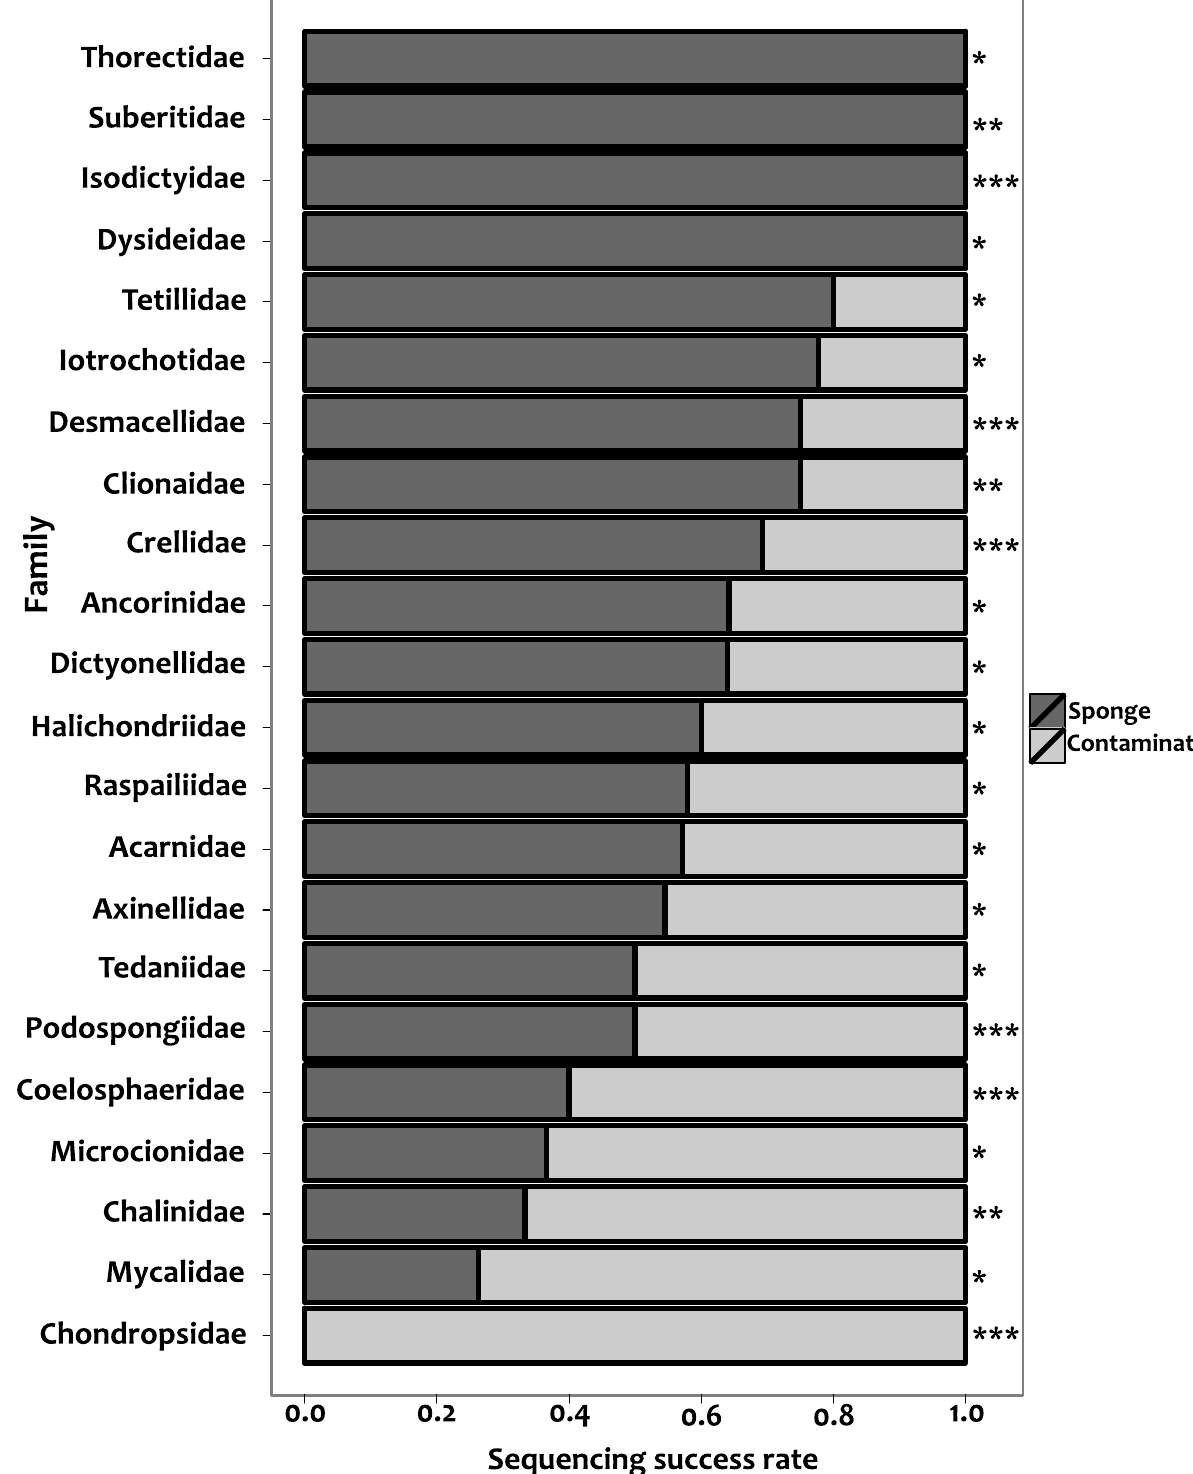
Figure 2. Sequencing success rates per sponge family. Grey and black colours represent sequences corresponding to non-target organisms and poriferans, respectively. The included families correspond to the families used for the analysis of PCR success, and were analised in the generalised linear model. Asterisks on the right side correspond to the different family groups analysed: *: Acarnidae, Ancorinidae, Axinellidae, Dictyonellidae, Dysideidae, Halichondridae, Iotrochotidae, Microcionidae, Mycalidae, Plakinidae, Raspailidae, Tedaniidae, Tetillidae and Thorectidae; **: Chalinidae, Clionaidae and Suberitidae; ***: Chondropsidae, Coelosphaeridae, Crellidae, Desmacellidae, Isodictyidae and Podospongiidae.